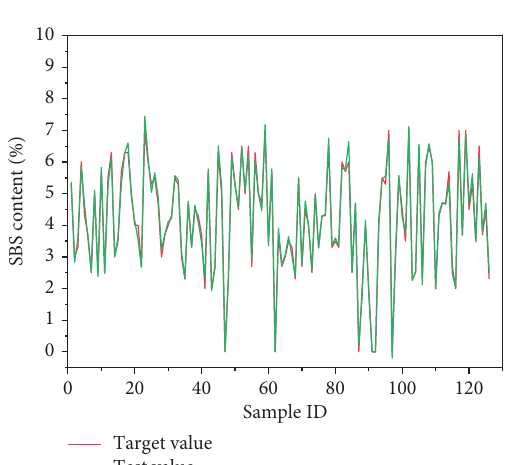
Figure 11: Correlation between the target value and the mean predicted value calculated by